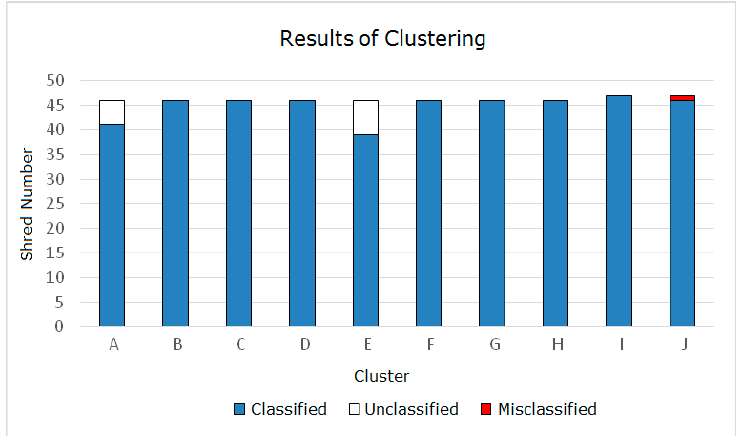
Figure 24. Results of processing residual sparse pieces.